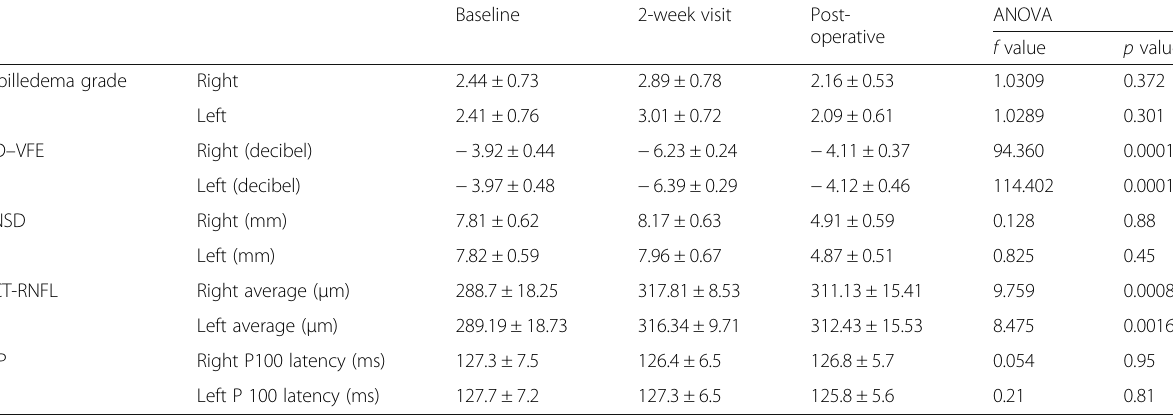
Table 2 Follow-up neuro-ophthalmological assessments for progressive IIH patients who needed lumpo-peritoneal shunts (group